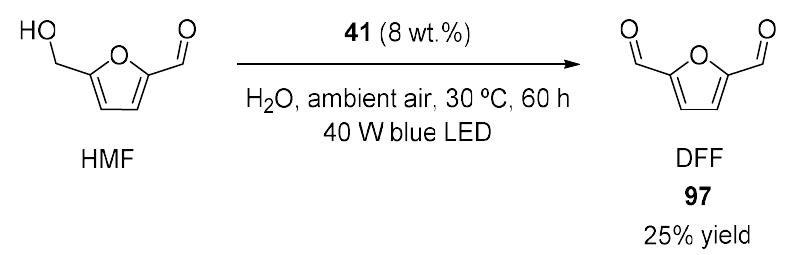
Figure 29. Results obtained in the aerobic photo-oxidation of alcohols to aldehydes or ketones 69 catalyzed by 95 and 96 .